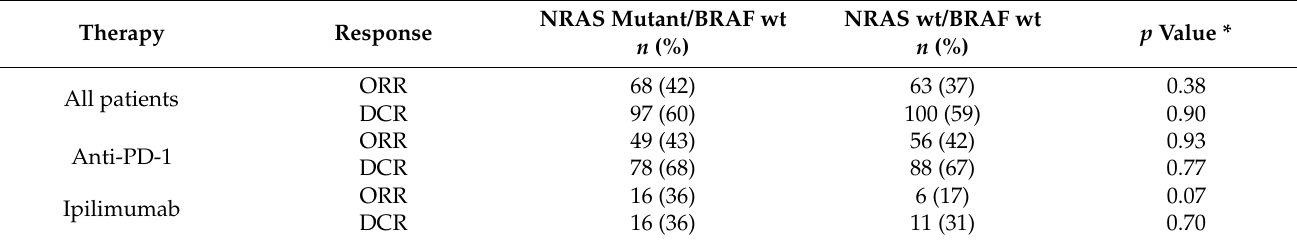
Table 4. Overall response and disease control rate in the 2 cohorts of